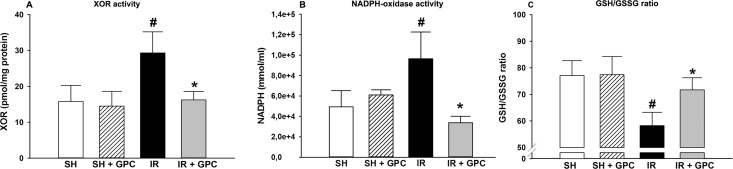
(A) XOR activity; (B) NADPH oxidasesactivity; (C) GSH/GSSG ratio. Animalsweresubjectedto 60 min of liverischemiafollowedby 60 min of reperfusion (IR group, blackcolumn) orweresham-operated (SHAM group, whitecolumn). 16.56 mg/kg GPC administrationwasstarted 5 min beforethe end of ischemia (IR+GPC group, greycolumn), oratidenticaltimepointinsham-operatedanimals (SHAM+GPC group, whitestriatedcolumn). XOR activity (inpmol/mg protein); NADPH oxidasesactivity (inmmol/ml). Data arepresentedasmeans ± SEM. #P< 0.05 vs SHAM group; *P< 0.05 vs IR group (one-way ANOVA, Holm-Sidak test).